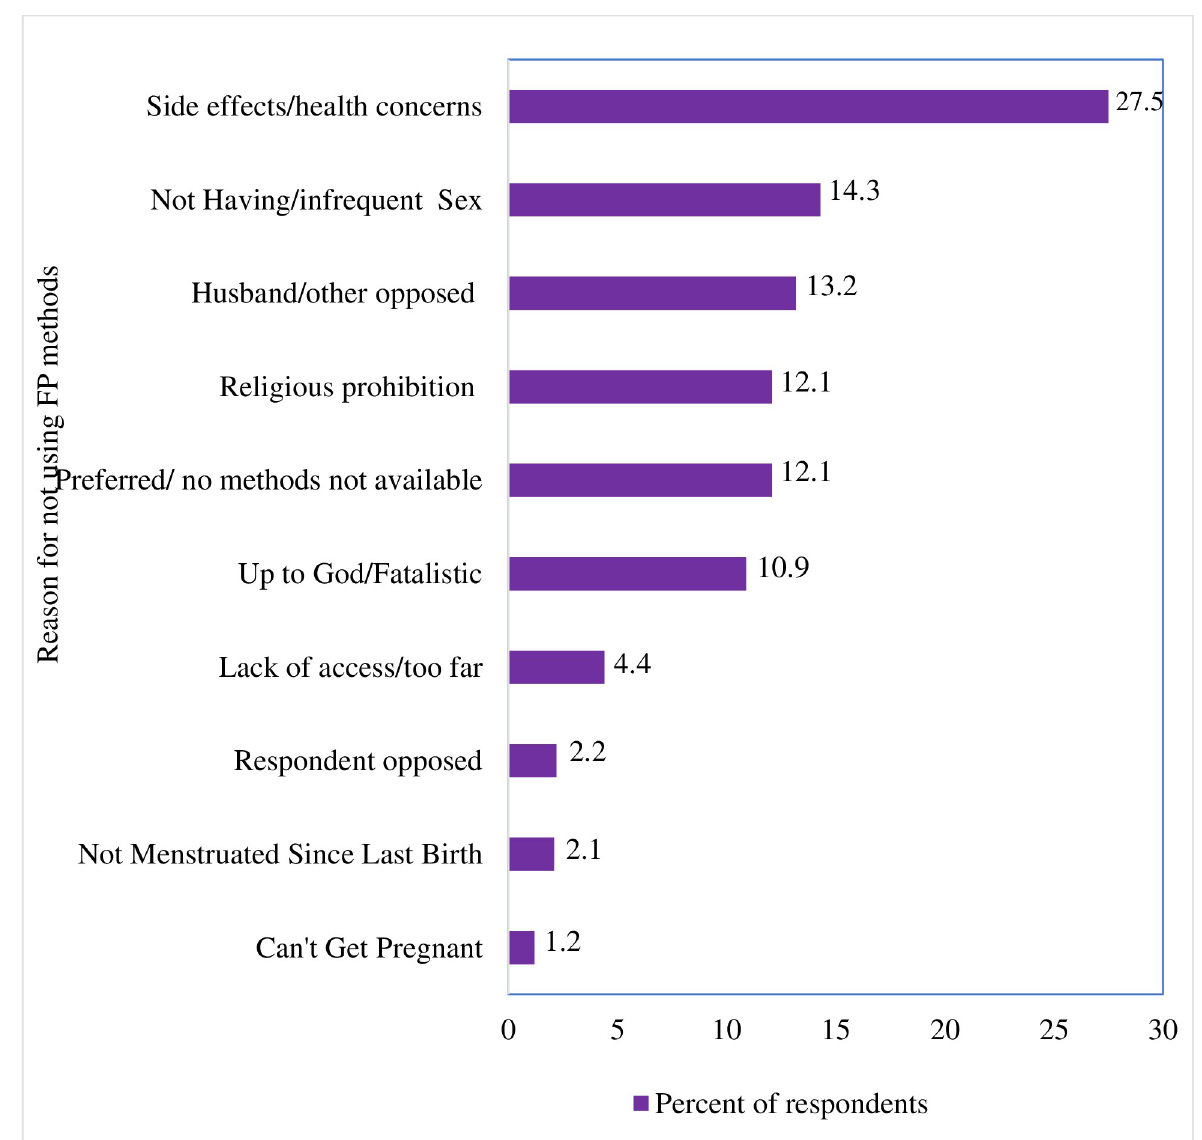
Fig 4. Perceived reasons for not using FP methods among HIV-positive